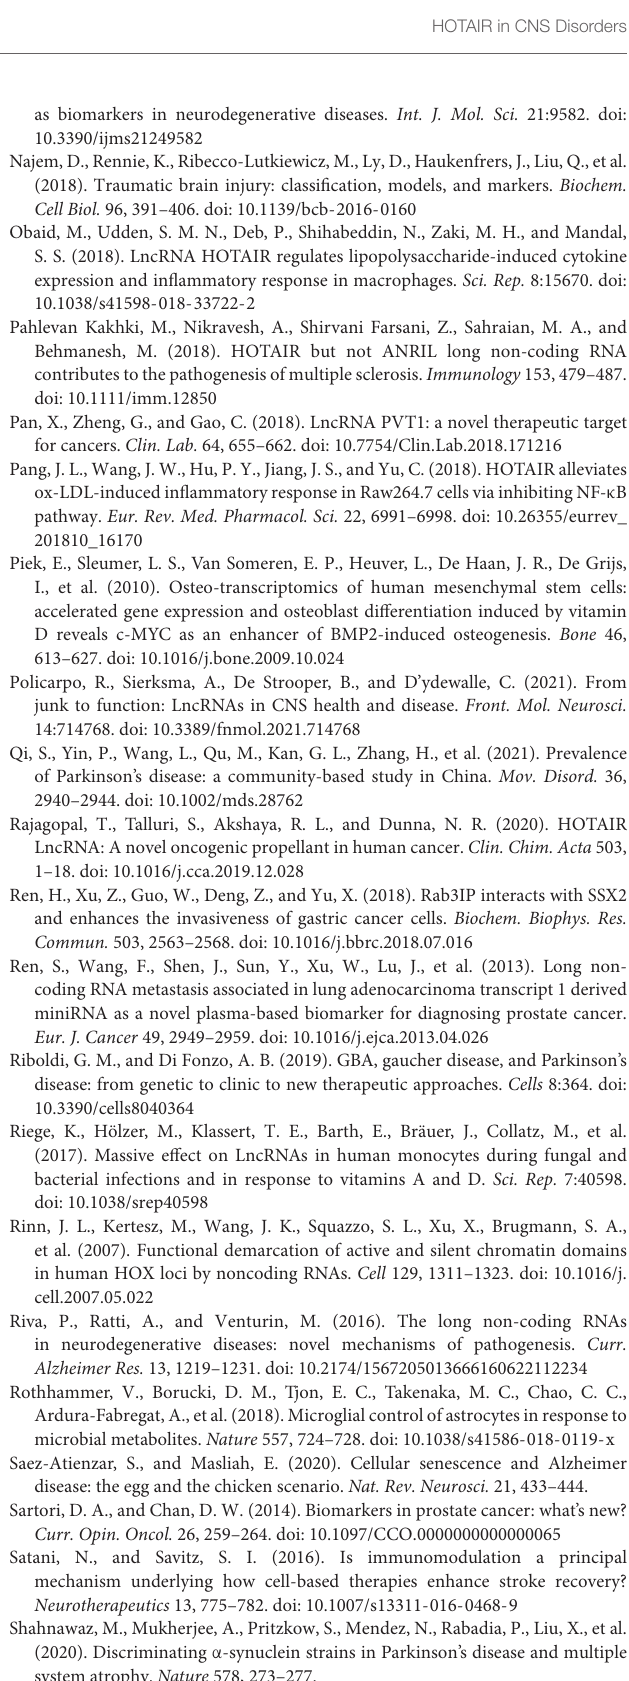
(2020). Discriminating α -synuclein strains in Parkinson’s disease and multiple system atrophy. Nature 578, 273–277.